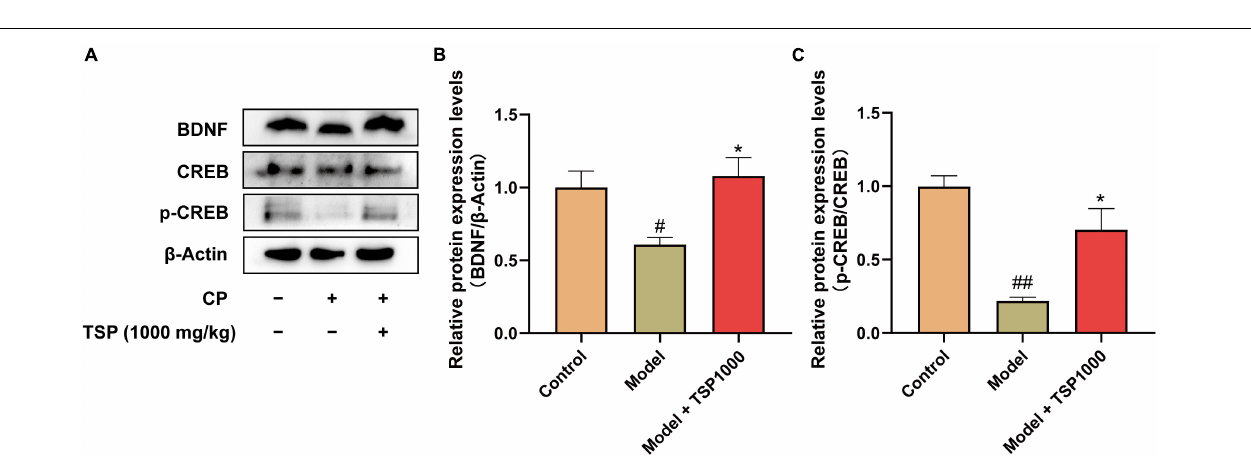
FIGURE 8 | The effects of TSP on the BDNF/TrkB/CREB signaling pathway. (A) The representative images of western blotting results. Quantification of the protein expression of BDNF (B) , p-CREB/CREB (C) . All data were expressed as mean ± SEM ( n = 3). # P < 0.05, ## P < 0.01 vs. Control group; * P < 0.05 vs. Model group.